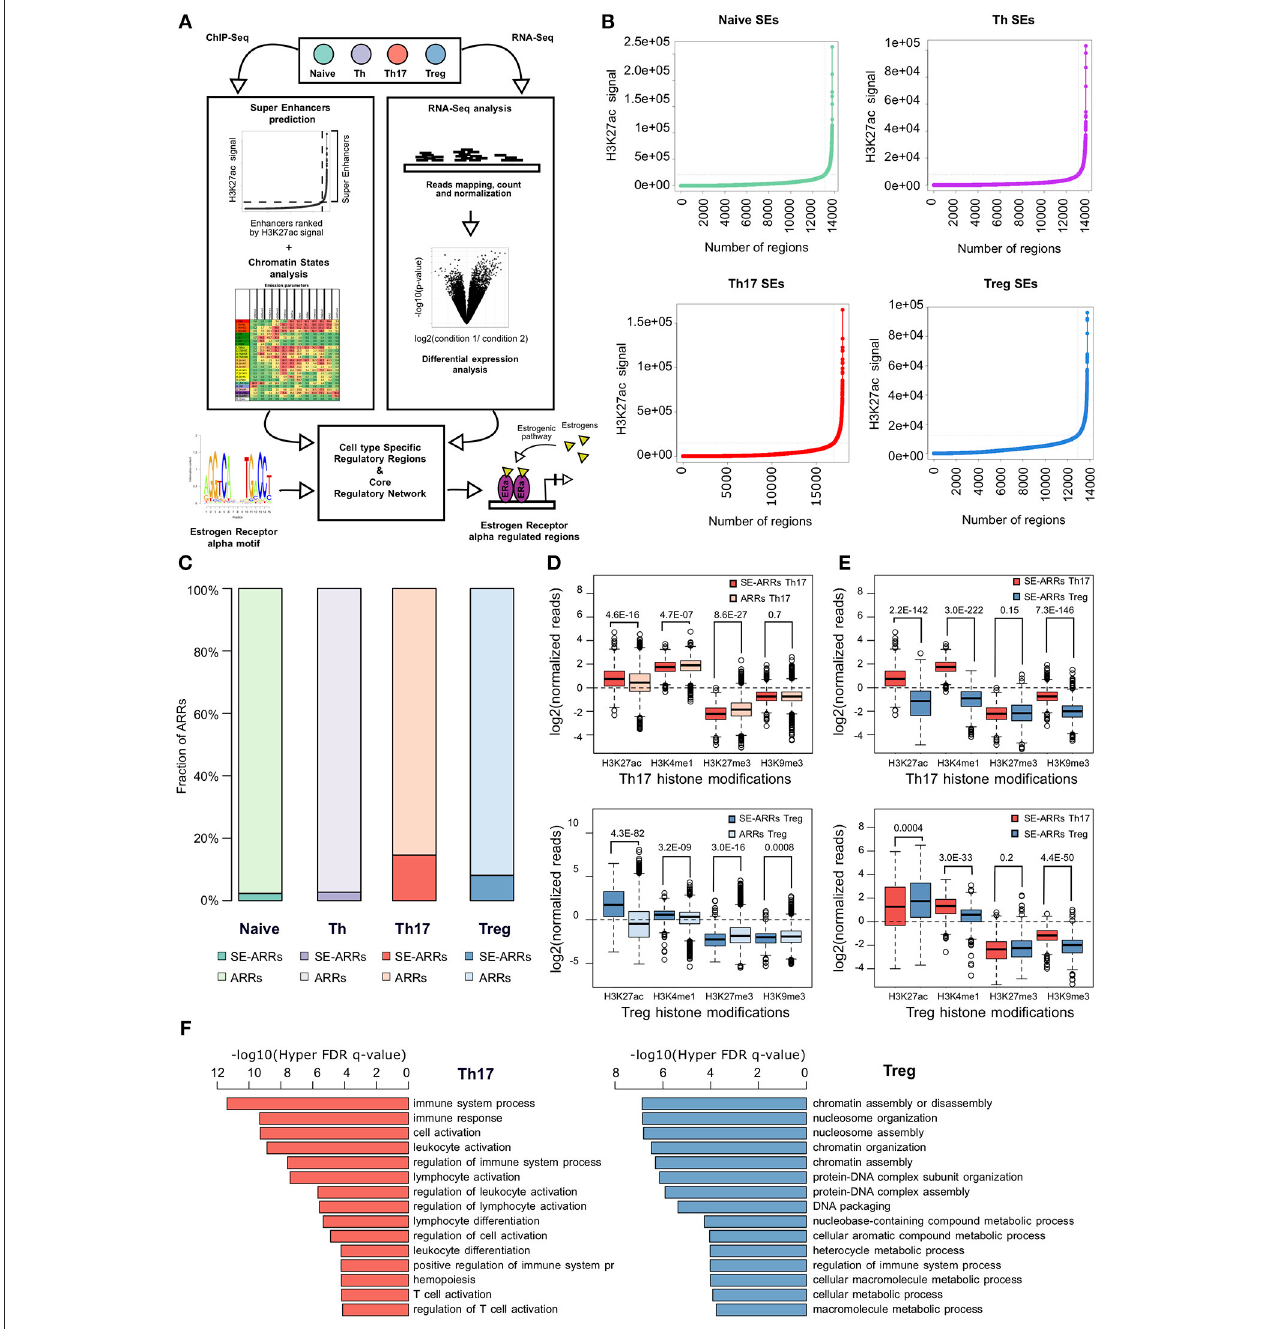
FIGURE 1 | Active regulatory regions within super enhancers of CD4 + T cell subtypes (A) Workflow representation of our approach for data integration. SEs prediction in CD4 + T cell subtypes and chromatin states analysis were used for identification of active regulatory regions (left side). Overlap between these regions defines SE-ARRs. DE Gene expression analysis led to the identification of main TFs involved in Th17 and Treg lineage determination (right side). Finally, we reconstructed a SE-ARRs-associated TFs regulatory network in Th17 and Treg cells. By this analysis, we identified putative targets of ER α -mediated regulation in Th17 and Treg cells. (B) Prediction of SEs in Th17, Treg, Naive T, and Th cells by Rank Ordering of Super Enhancers (ROSE) algorithm. Line plot reports the cumulative number of enhancers identified in Th17 and Treg cells as function of the number of H3K27ac ChIP-Seq reads over the input dataset. Vertical lines represent the threshold over which H3K27ac signal intensity defines SEs. (C) Bar plot shows the fraction of ARRs overlapping SEs in Th17 and Treg. (D,E) Box plot shows the log2 normalized H3K27ac, H3K4me1, H3K27me3, and H3K9me3 ChIP-Seq signal measured in Th17- (D) and Treg- (E) SE-ARRs. On right panels SE-ARRs comparison with ARRs. P -value by Wilcoxon Rank-sum test. (F) Bar plot shows top 15 most significant Gene Ontology Biological Processes enriched by Genomic Regions Enrichment of Annotations Tool (GREAT) for genes mapped in proximity of Th17 (left) and Treg (right) SE-ARRs.